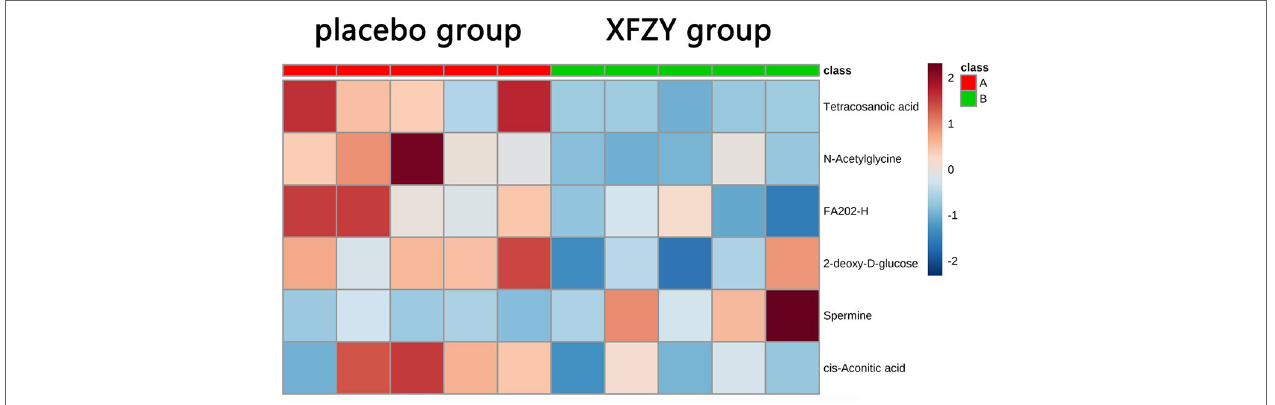
FIGURE 2 | The six differential metabolites in the two groups are shown in the heat map using MetaboAnalyst 4.0 (A: placebo group; B: Xuefu Zhuyu decoction group). The row represents the metabolites, and the column represents the individual samples. Red bands indicate upregulated metabolites, and blue bands indicate downregulated metabolites in the two groups. The deeper the color, the greater the difference in metabolites.